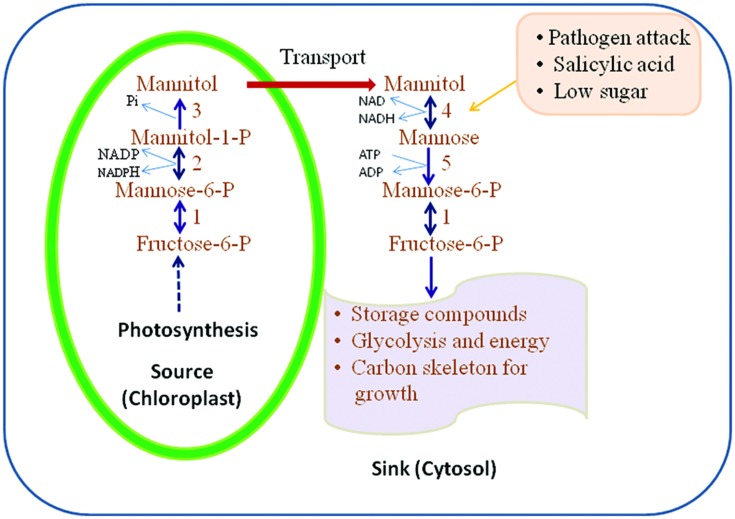
Mannitol biosynthesis and catabolism as proposed in higher plants. 1, mannose; 6-P isomerise; 2, mannose-6-P reductase; 3, mannitol-1-phosphate dehydrogenase (M1PDA); 4, mannitol-1-dehydrogenase; 5, hexokinase (HX; adapted and modified from Stoop et al., 1996).